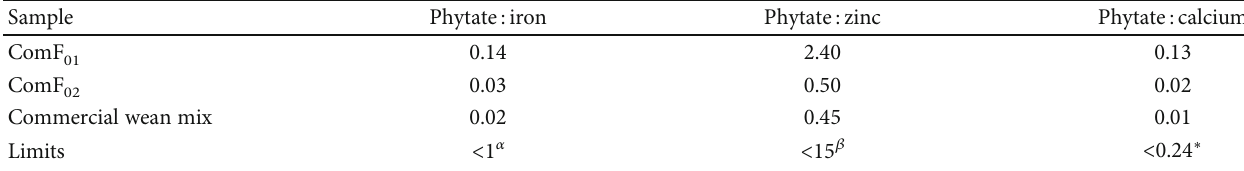
Table 6: Minerals :phytate molar ratio in developed complementary foods and commercial wean mix. Sample